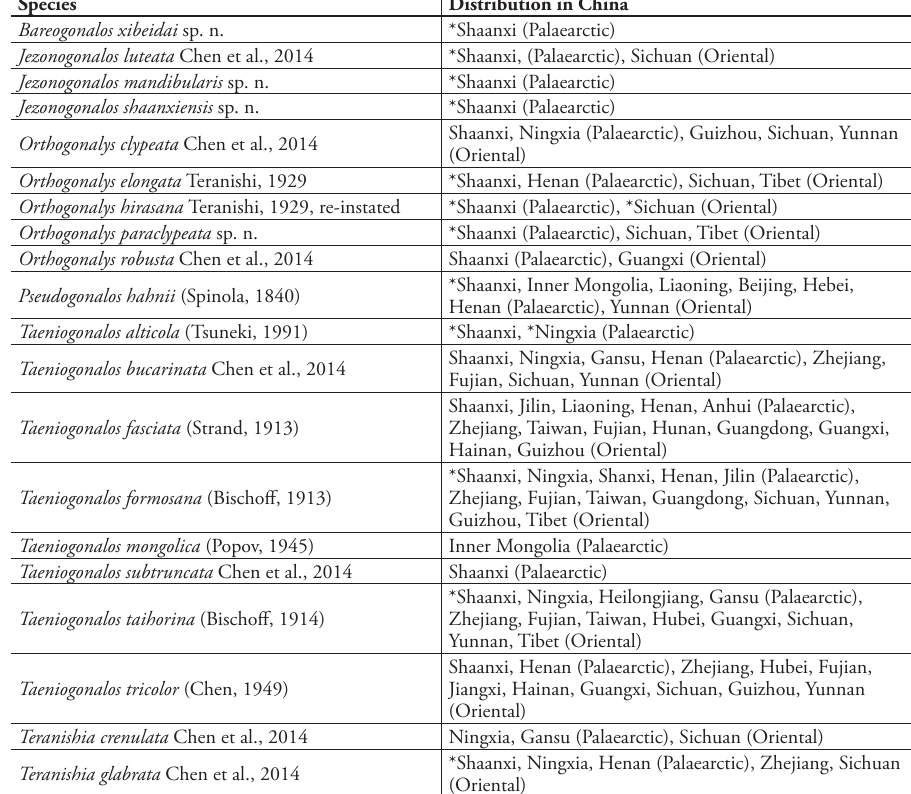
Table 1. List of Chinese species of the family Trigonalyidae Cresson in NW China after this study. An asterisk indicates a new